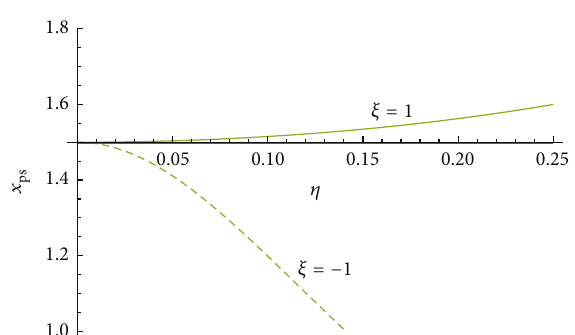
Figure 3: Radius of photon sphere ( 𝑥 ) versus 𝜂 . Solid and dashed ps green curves correspond to the case of ordinary and phantom global monopoles whereas the solid red line indicates Schwarzschild